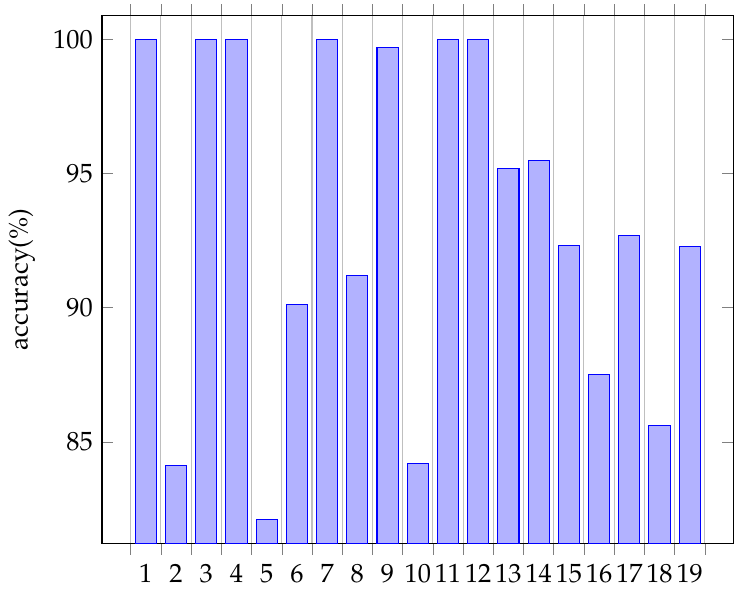
Figure 9. Character recognition rates for scanned table images. Figure 11. Character recognition rates for scanned table